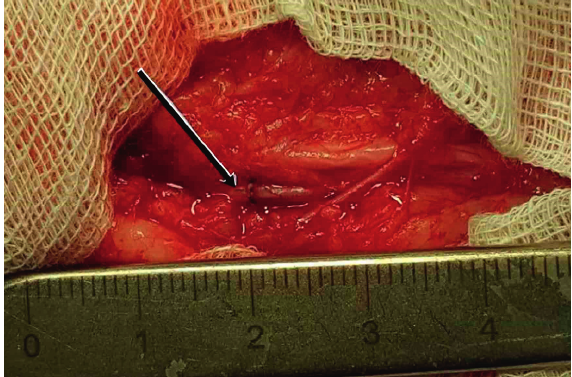
Figure 4: Brachial artery aneurysm resected and end-to-end anastomosis